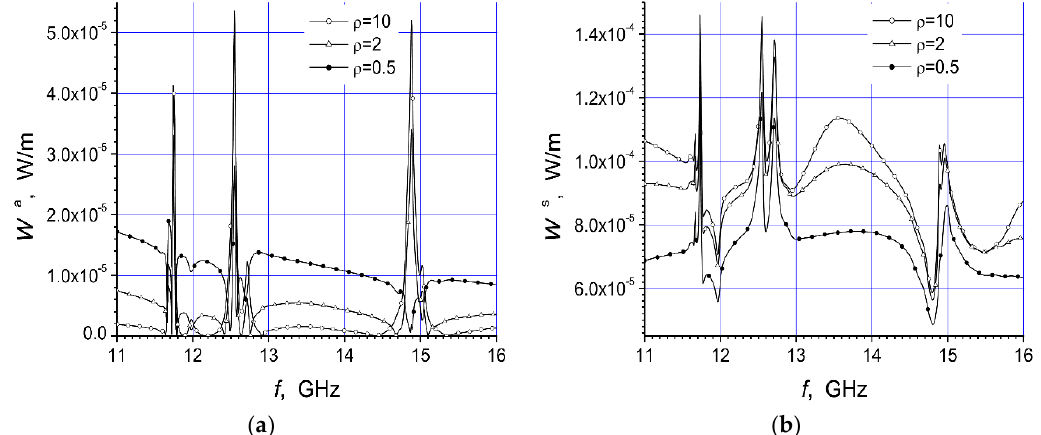
Figure 3. Dependencies of absorbed power ( a ) and scattered power ( b ), of the array Figure 1b, on the frequency of the parallel polarized incident wave at R = 12 mm.